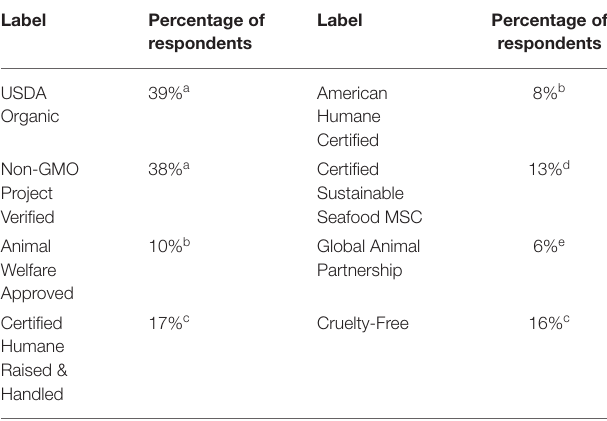
TABLE 3 | Labels 1 respondents look for when buying meat